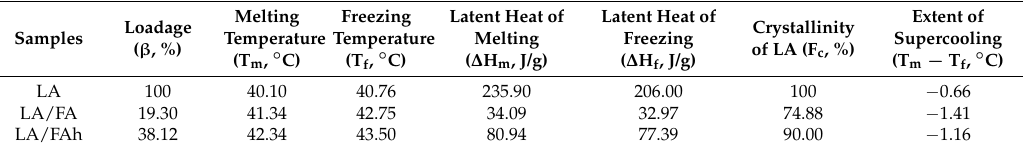
Figure 5. DSC curves of pure LA, LA/FA and LA/FAh. Table 3. Thermal properties of pure LA, LA/FA and LA/FAh